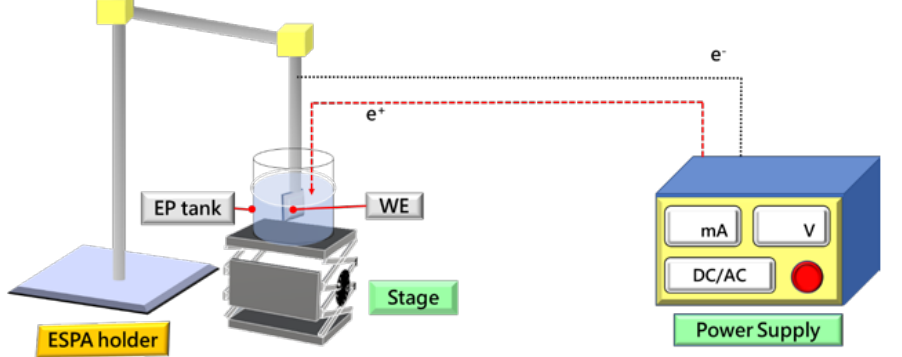
Figure 2. Schematic diagram of the experimental setup for the EPSA method.